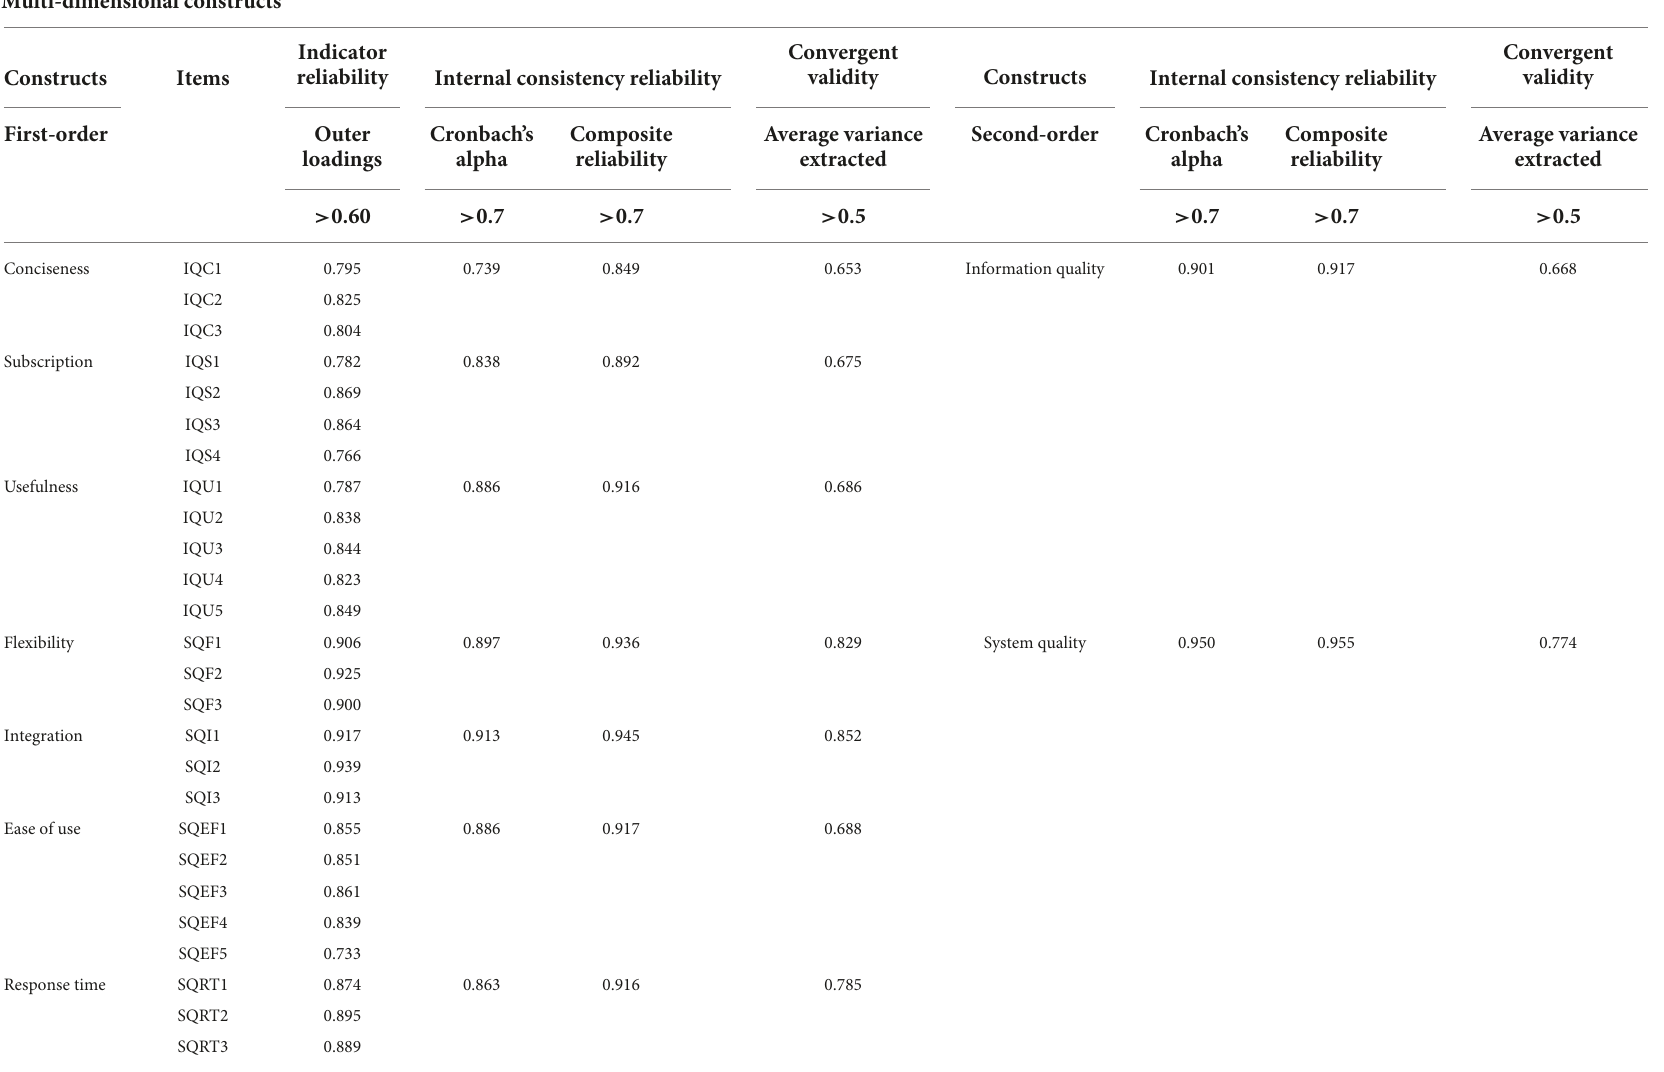
TABLE 3 Results summary for reflective measurement